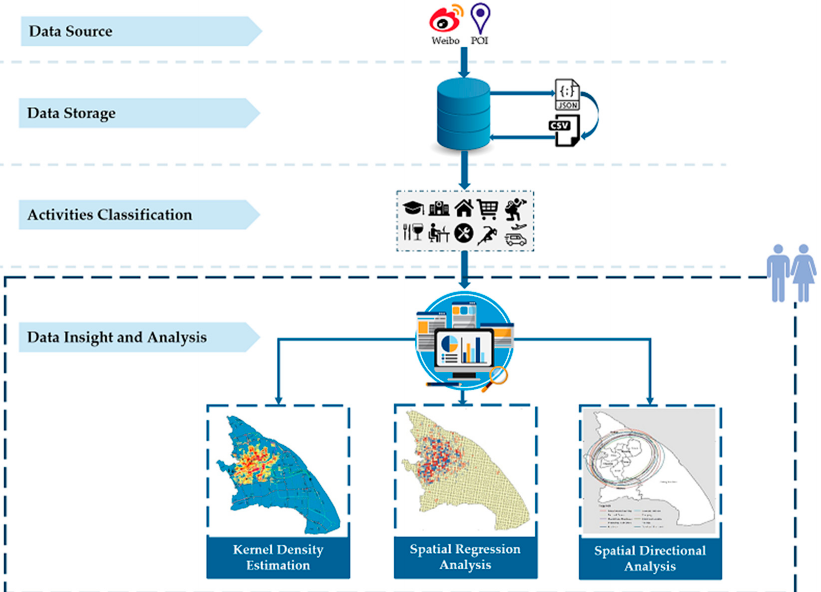
Figure 2. Activities behavior analytics.